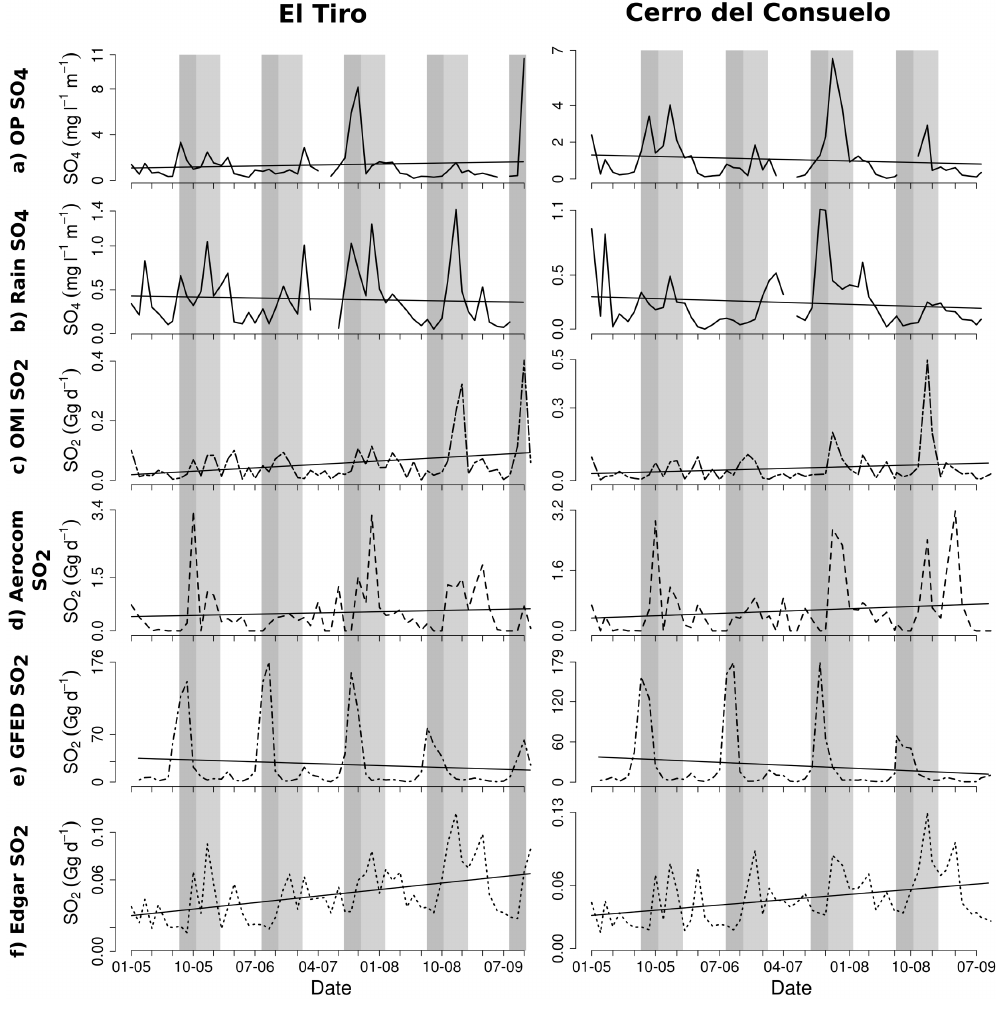
Figure 5. Time series comparing SO 2 transport from (c) volcanic and strong anthropogenic regional emissions (OMI), (d) volcanic emissions (Aerocom), (e) biomass-burning emissions (GFED), and (f) anthropogenic emissions (EDGAR), to measured sulfate concentrations in (a) occult precipitation (OP) and (b) rainwater from Cerro del Consuelo (right panel) and El Tiro (left panel) meteorological stations (MSs). The black straight line represents the line of best fit. Dark grey bars depict the Amazonian biomass-burning season (easterly wind direction) and light grey bars, the shift of the incoming air masses towards a northerly/northwesterly/westerly direction. Note the different scaling of the y